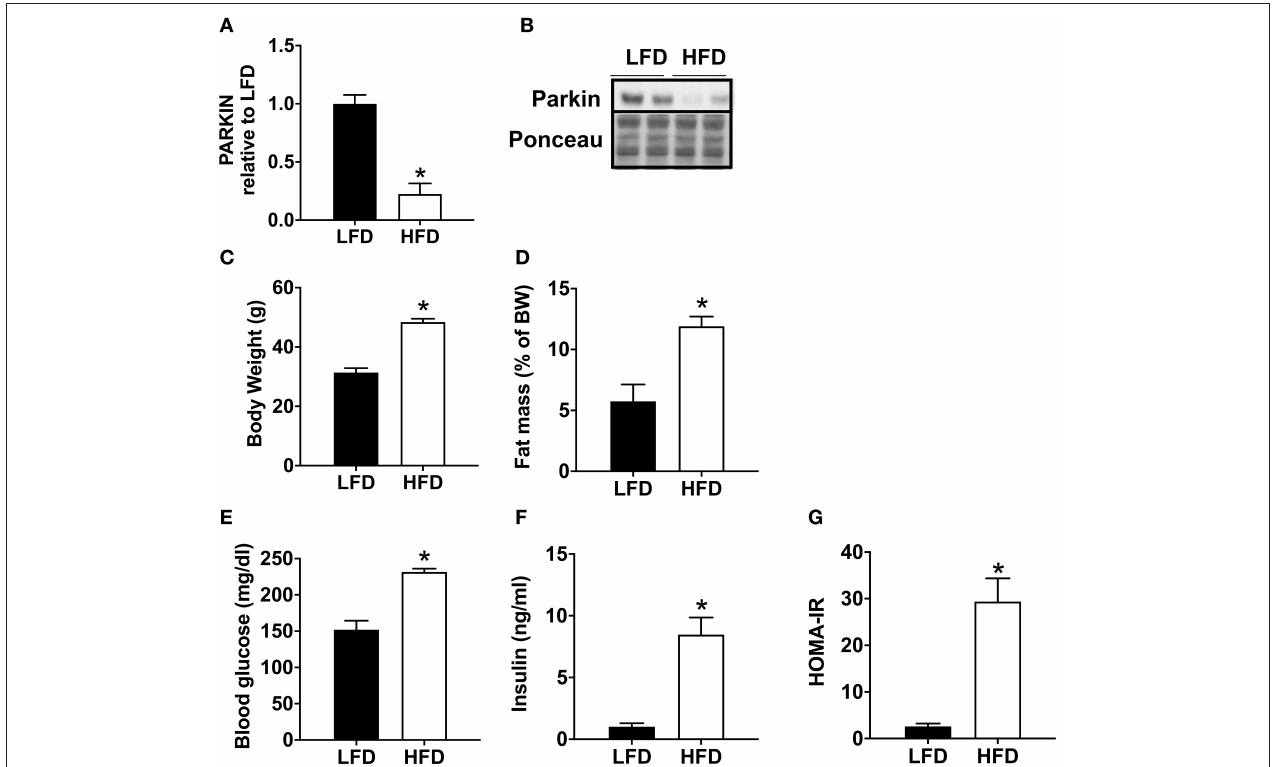
FIGURE 1 | Decrease of cardiac Parkin protein level in mice after 12 weeks of HFD. The protein expression of Parkin was quantified by densitometric analysis (A) after Western blot analysis (B) in LFD and HFD mice at baseline (no ischemia reperfusion, fed ad libitum ). Body weight (C) was monitored after 12 weeks of LFD or HFD. The fat mass was calculated after measurement of adipose tissue mass after sacrifice (D) . After 1 weeks of HFD, plasma glucose (E) and insulin (F) levels were determined in mice fasted for 6h and HOMA-IR was calculated (G) . Results ( n = 5–8/group) are expressed in mean ± SEM; * p < 0.05 vs.